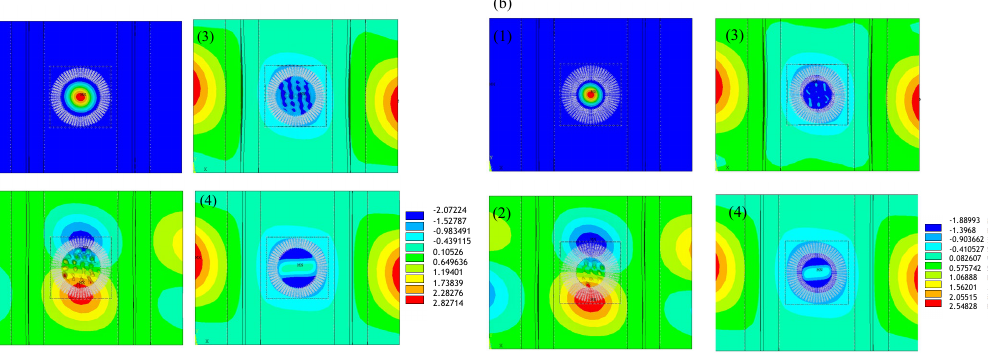
Figure 9. Out-of-plane displacement contour plot: (1) buckling of circular delamination, (2) buckling of the skin, (3) global buckling including stringers and (4) delamination initiation, with ( a ) CD9 and ( b ) CD10.